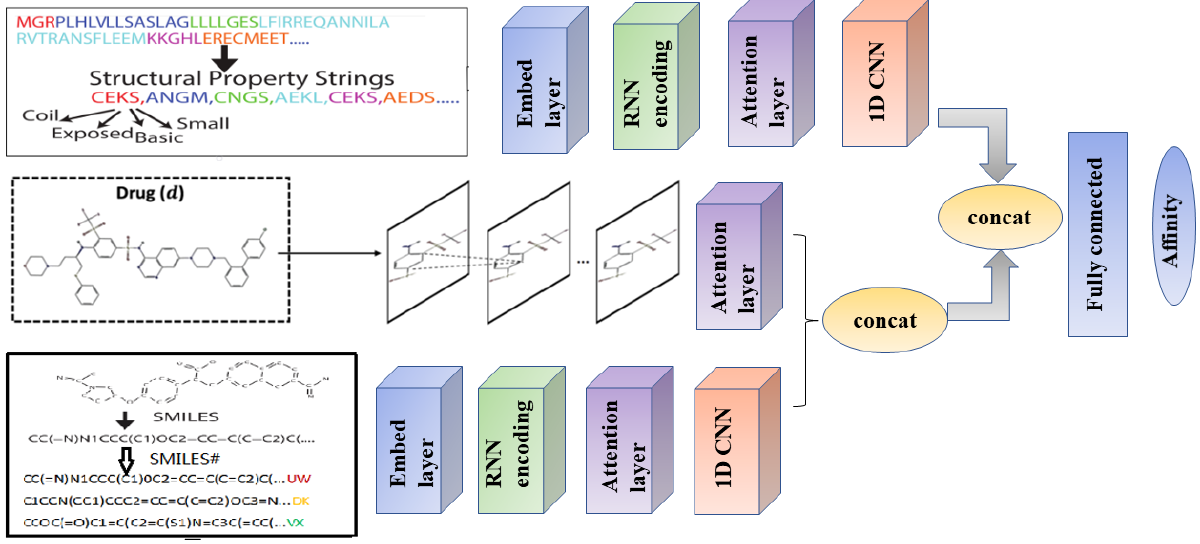
Figure 5. The overall flow chart of the SSGraphCPI model.